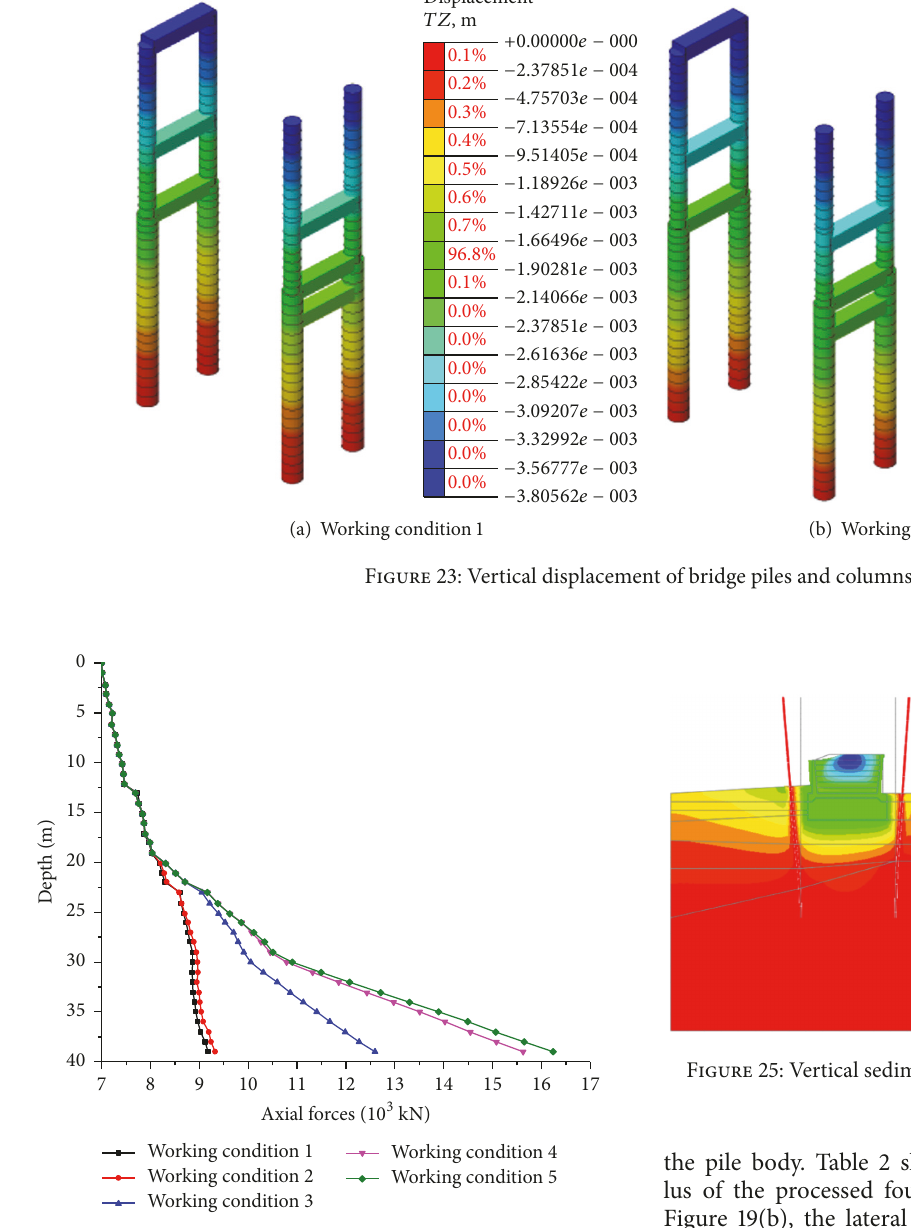
Figure 24: Axial forces of bridge piles and columns.